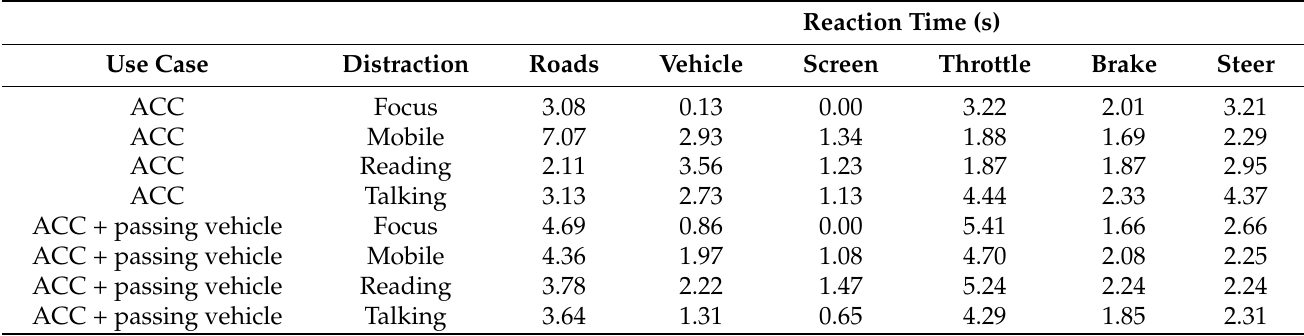
Table 4. Reaction time for the different experiments performed.